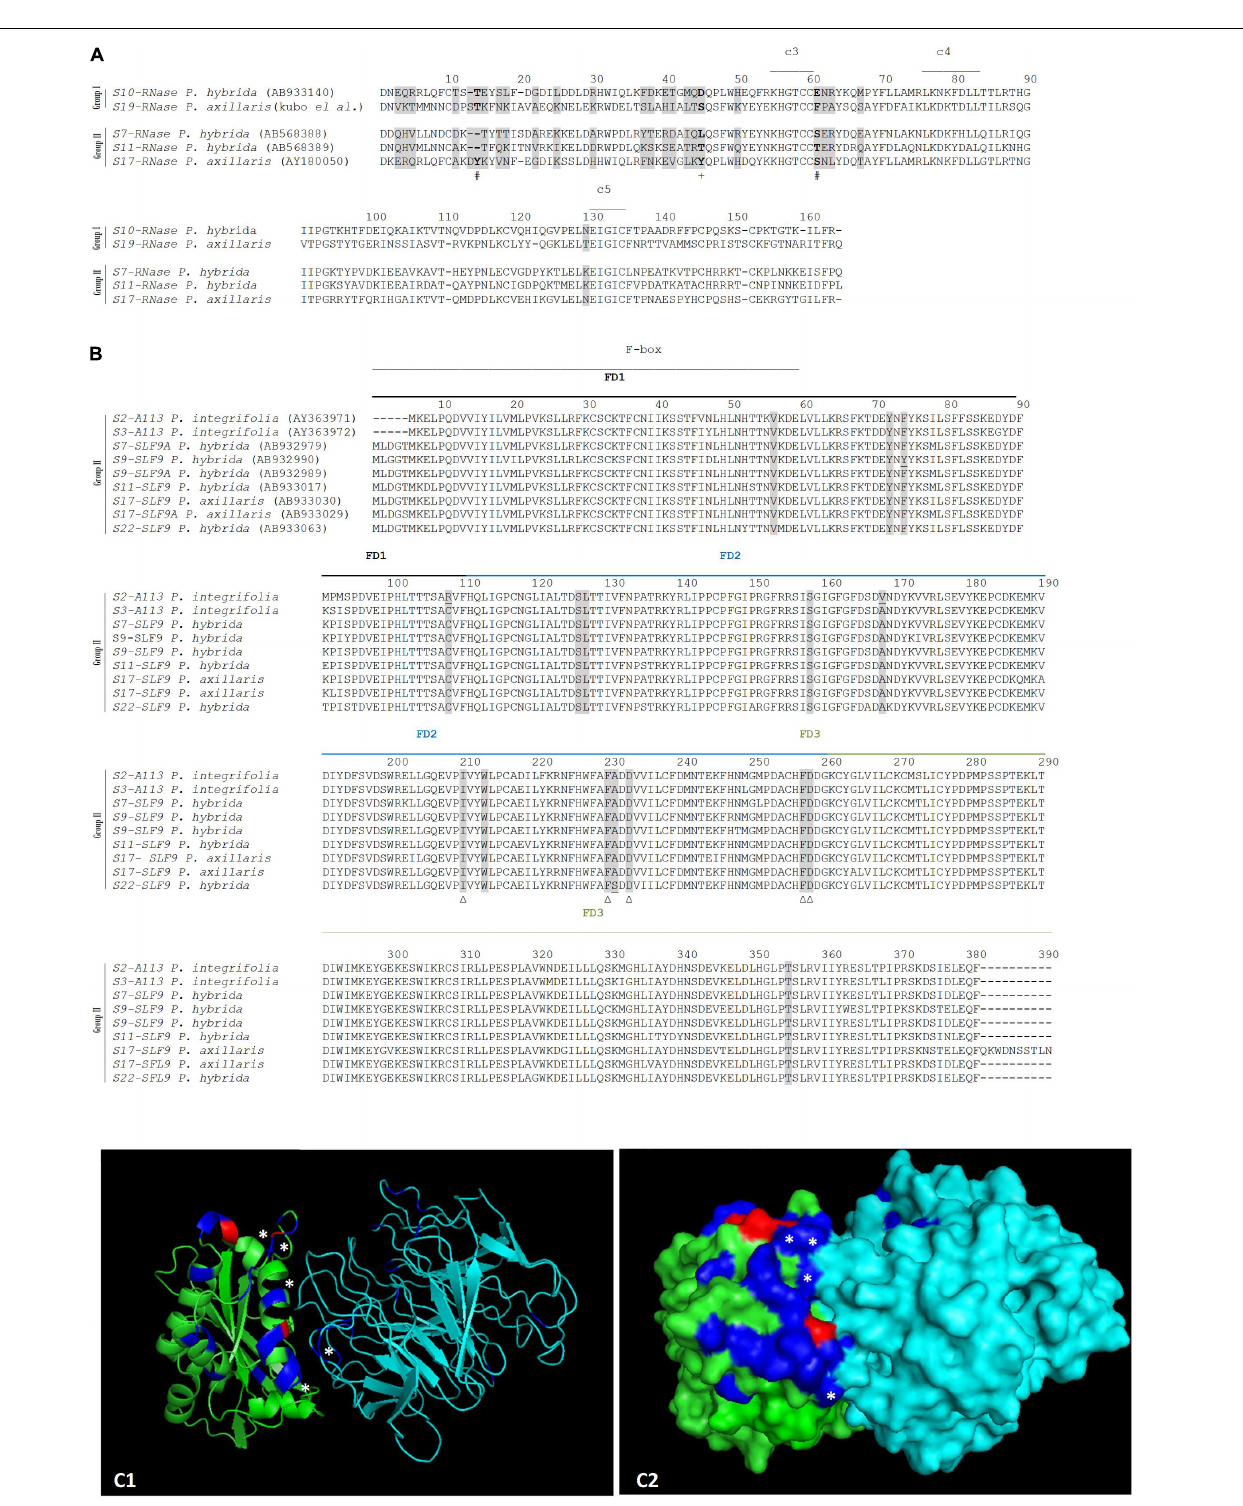
FIGURE 4 | Positively selected amino acid sites at the S-RNase (A) , SLF9 (B) alignments (highlighted in gray), and in the predicted docking structure of P. hybrida S11-SLF9/S19-RNase (as cartoon C1, and surface C2) predicted to be involved in the recognition of S10 -, and S19-RNase (group I) as non-self by the S2-, S3-S7-, S9-, S11-, S17-, and S22-SLF9A and SLF9B (group II), all showing high sequence conservation. (A) The conserved regions (C3- C5) are marked. The three amino acid positions under positive selection that are different between the two groups are highlighted in bold. Differences in size are marked with a #, and